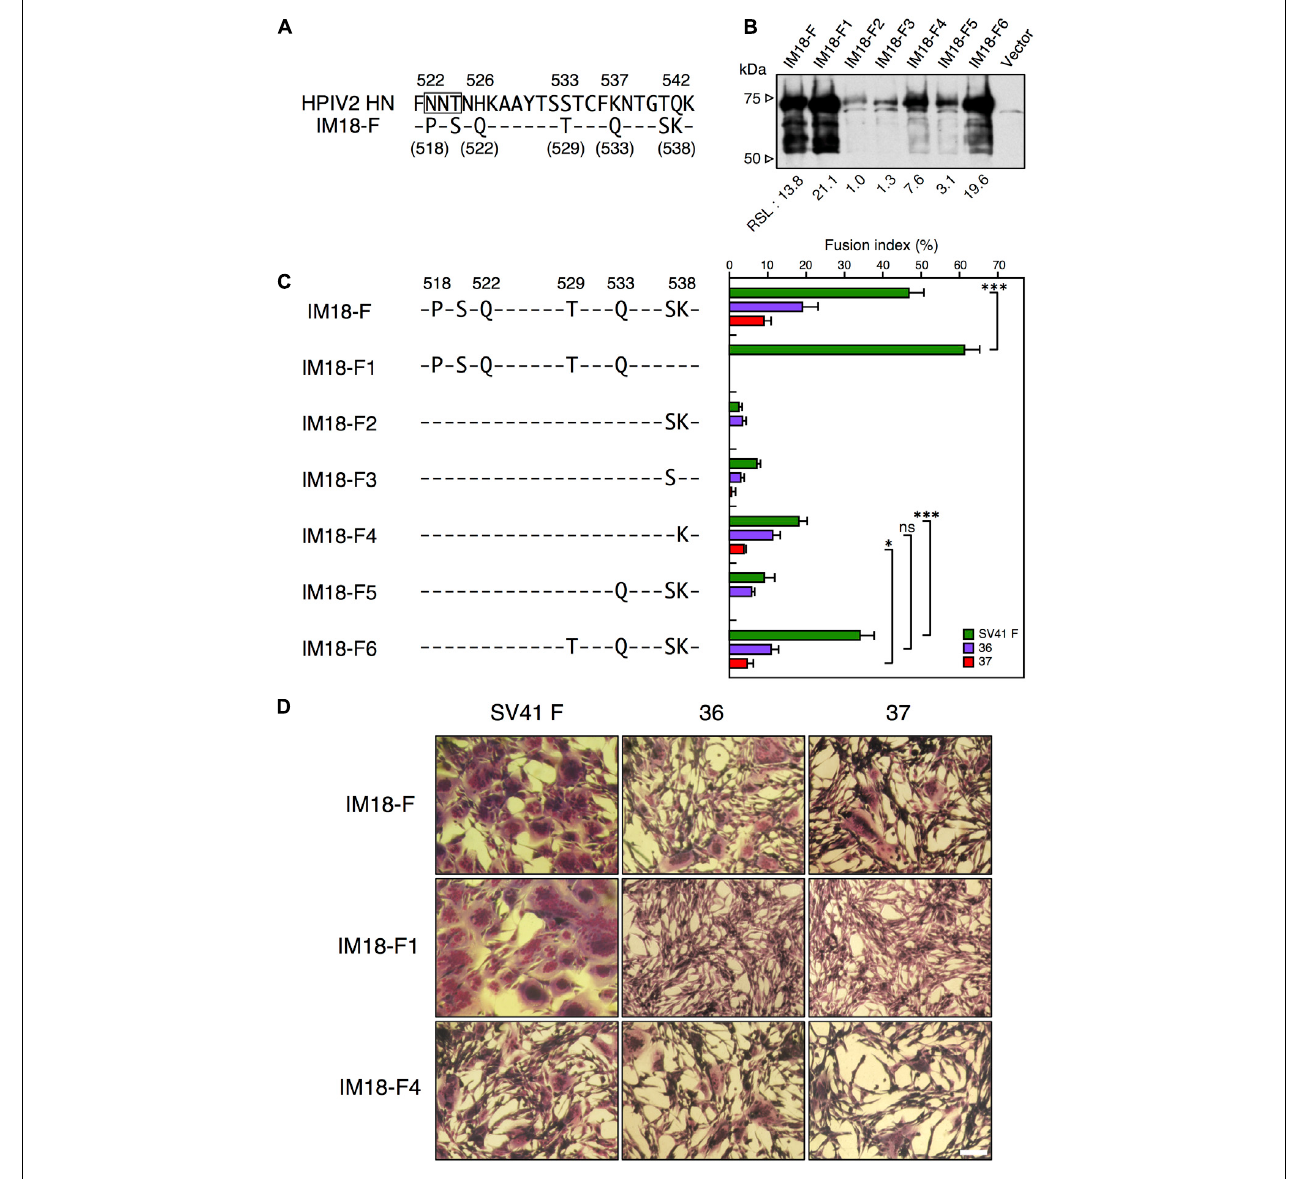
FIGURE 7 | SV41 HN-derived K538 is indispensable for exhibiting the SV41 HN-like F protein specificity. (A) Amino acid sequence alignment of the segment F of the chimera IM18-F and the HPIV2 HN protein. Dashes in the IM18-F sequence indicate the amino acids identical to the HPIV2 HN counterparts. (B) Detection of cell surface-localized HN proteins. The cell surface-localized HN proteins were detected as described in the legend for Figures 4A,B . Vector: pcDL-SR α expression vector used as the negative control. RSL, relative surface localization. (C) F protein specificity of the HN proteins. The SV41 HN-derived amino acids in the segment F of the chimera IM18-F were replaced stepwise with the HPIV2 HN counterparts, resulting in six chimeric HN proteins. The average fusion index was determined at 24 h post transfection as described in the legend for Figure 2D ; error bars indicate standard deviation. The representative data of more than three independent experiments are shown. The fusion indices are not normalized to the cell surface-localization levels; the normalized data are shown in Supplementary Figure S8C . The statistical significance was evaluated by one-way ANOVA as described in the section “Materials and Methods” ( ∗ p < 0.05, ∗∗∗ p < 0.01, n = 10). ns, not significant. (D) Syncytia induced by co-expression of HN and F proteins. Subconfluent BHK cells grown in six-well culture plates were transfected with a mixture of 0.2 µ g/well of the pcDL-SR α expression vector encoding each HN protein and 2 µ g/well of the pcDL-SR α expression vector encoding each F protein. After 24 h of incubation at 37 ◦ C, the cells were fixed with 4% paraformaldehyde in PBS, treated with methanol, and stained with Giemsa’s solution. Bar, 100 µ m.